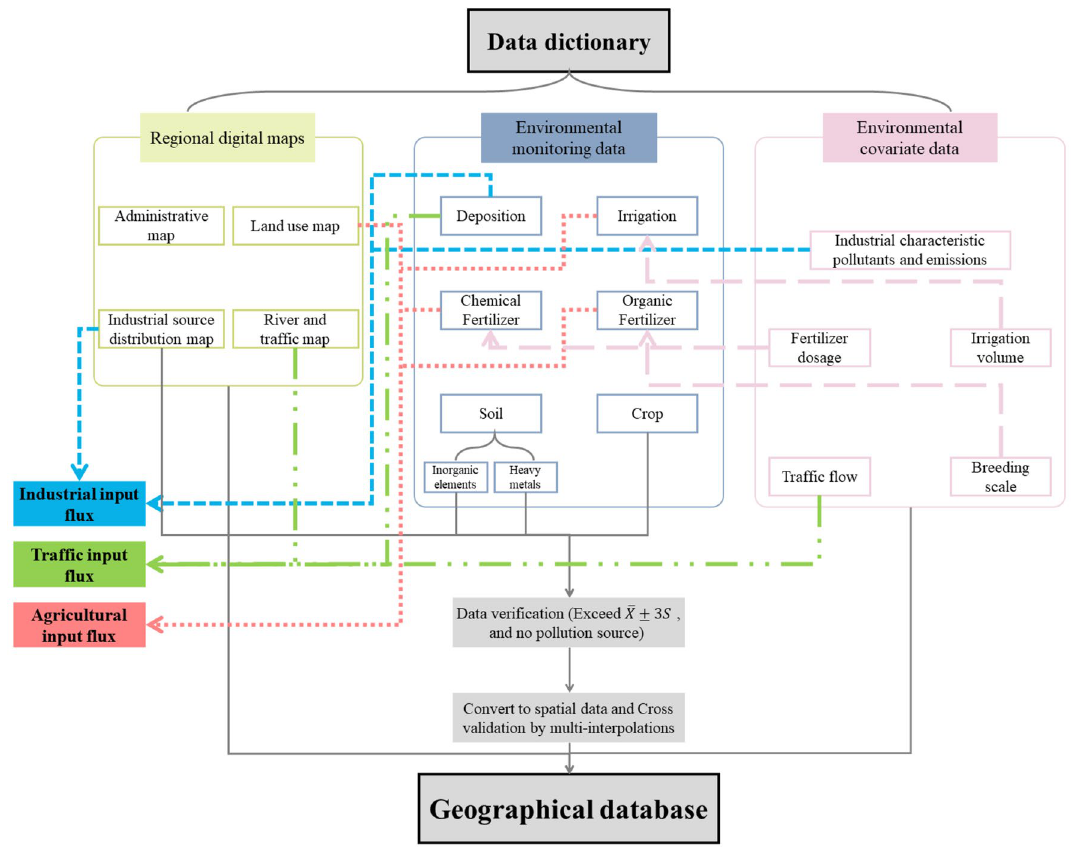
Figure 2. The high-dimensional geographical database.